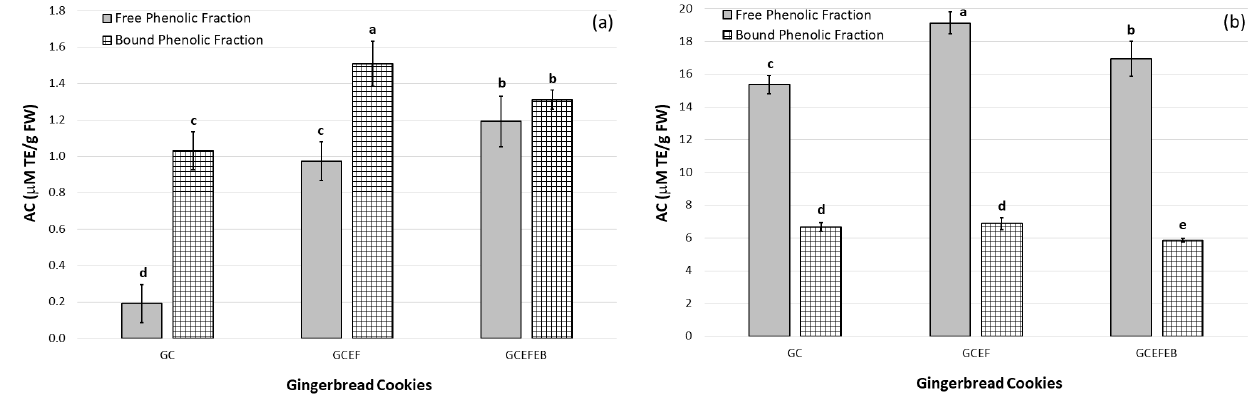
Figure 1. Antioxidant capacity (AC) results ( x ± SD , mean value ± standard deviation) of gingerbread cookies covered in chocolate without additives (GC), and with elderflower dry extract (GCEF), as well as enriched with elderberry juice concentrate (GCEFEB), determined by DPPH ( a ) and ABTS ( b ) assays. Different letters (a–e), separately for each assay, indicate significant differences (one–way ANOVA and Tukey’s test, p ≤ 0.05).